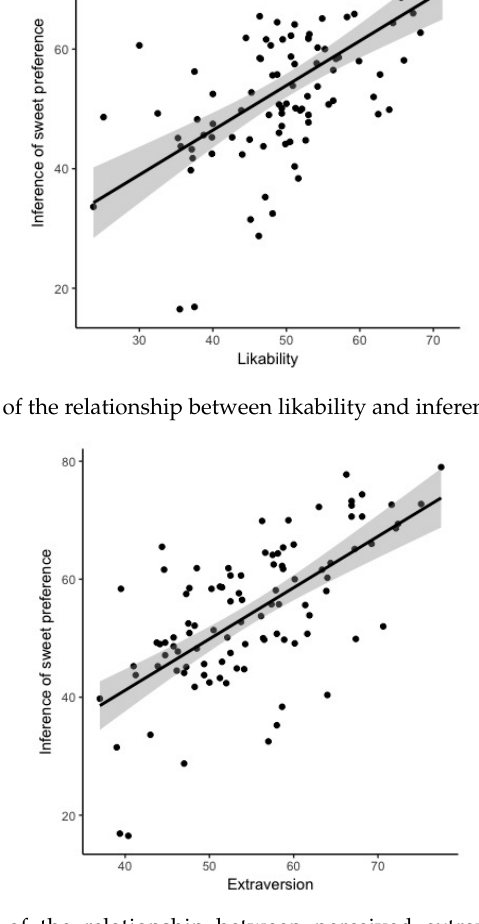
Figure A4. Scatterplot of the relationship between perceived extraversion and inferences of sweet preference.